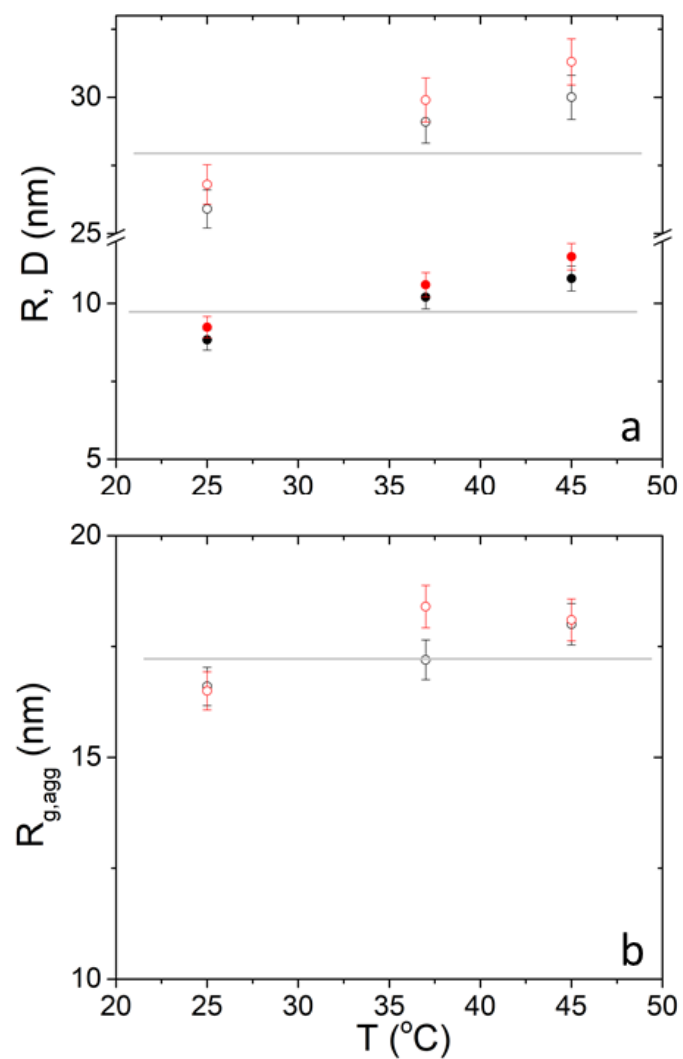
Figure 5. SANS-extracted R (closed circles) and D (open circles) ( a ) and R g , agg ( b ) from DPPC/PEO-b-PCL1 (black) and DPPC/PEO-b-PCL2 (red) at 30 mg mL − 1 . Horizontal lines are used as a guide to the eye.